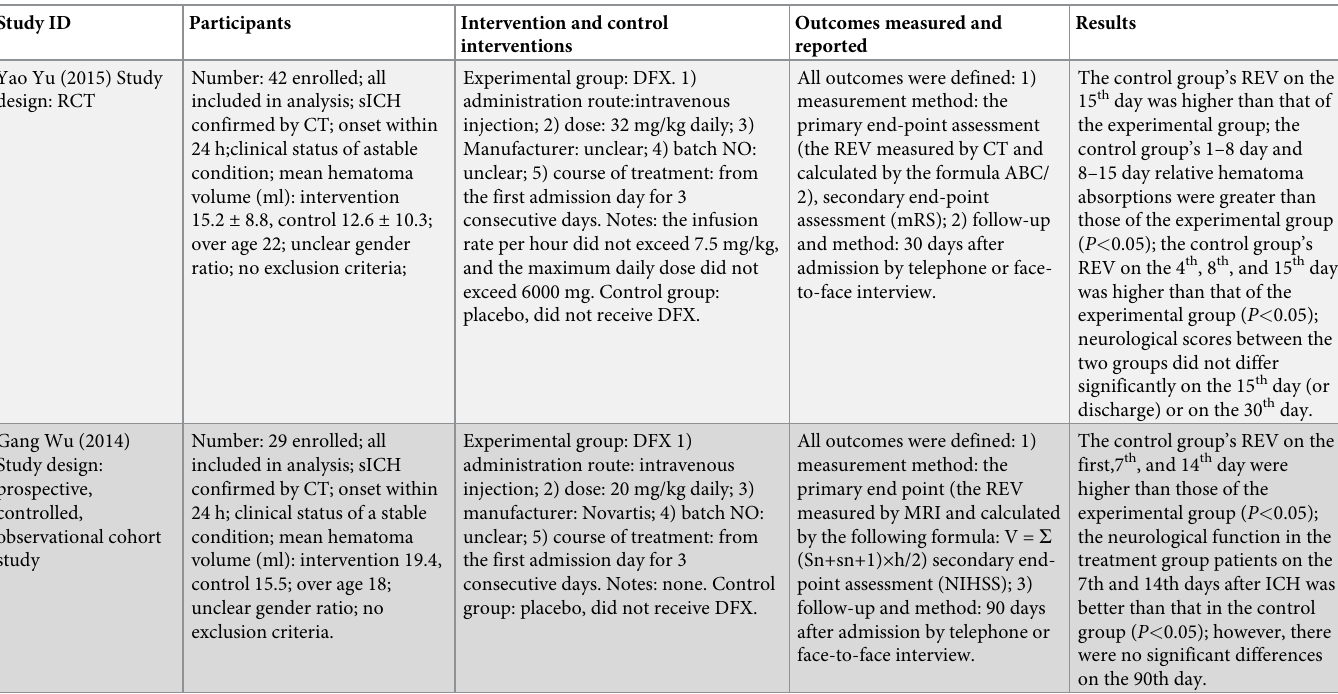
Table 3. Characteristics of the two included